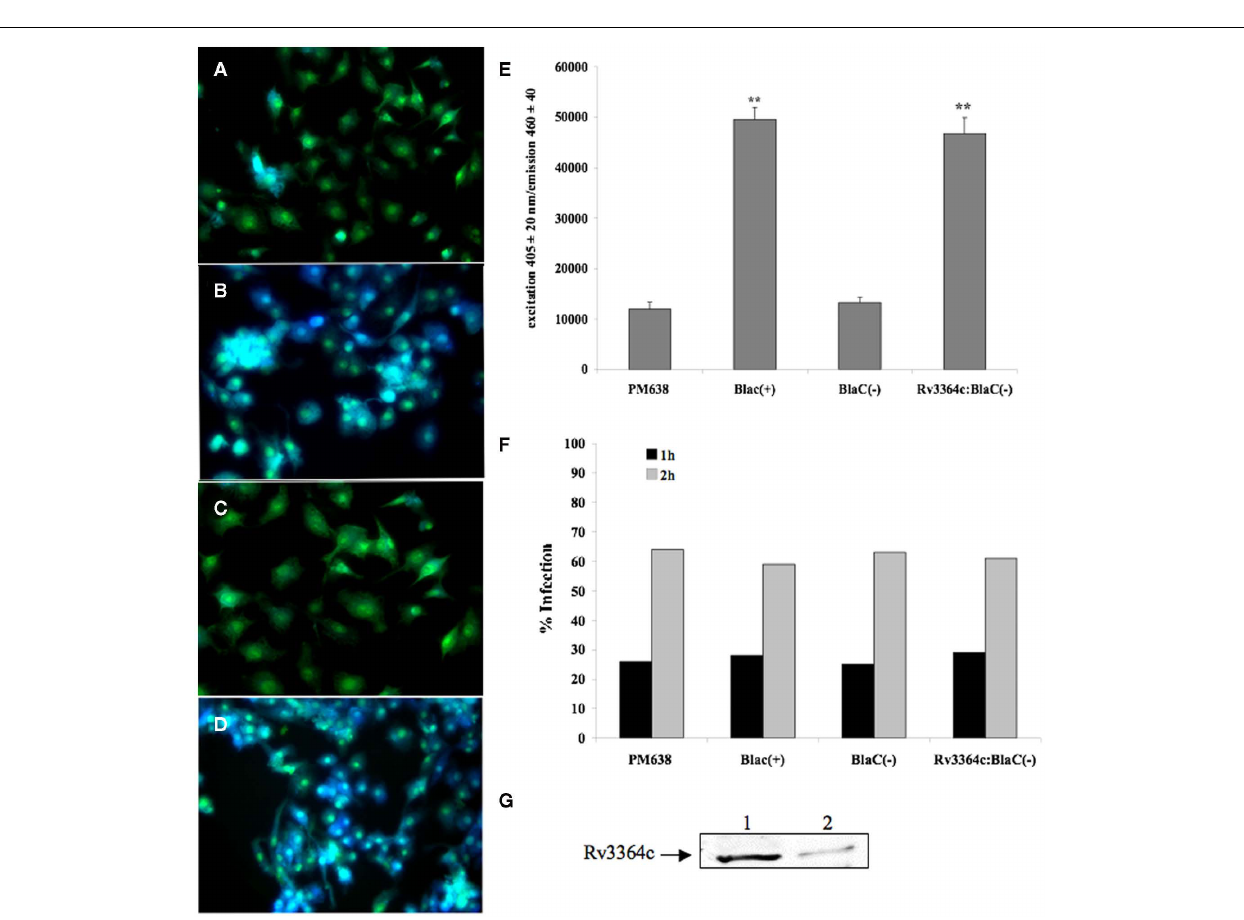
FIGURE 2 | Mycobacterium tuberculosis Rv3364c protein translocation into cytoplasm of U937 cells visualized by β -lactamase-catalyzed hydrolysis of cell-permeable CCF2 (FRET-based) substrate. β -Lactamase hydrolysis in (A) macrophages infected with M. tuberculosis BlaC deletion clone PM638; (B) cells infected with M. tuberculosis clone expressing full length BlaC protein; (C) macrophages infected with PM638 clone containing BlaC( − ) lacking a signal sequence; and (D) U937 cells infected with M. tuberculosis PM638 clone expressing Rv3364c:BlaC( − ).While